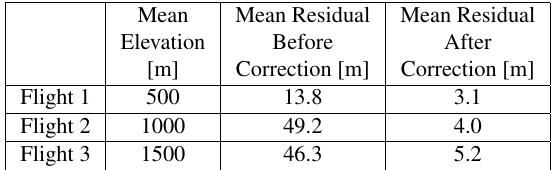
Table 1. comparison of mean residual before and after correction for three flights of different